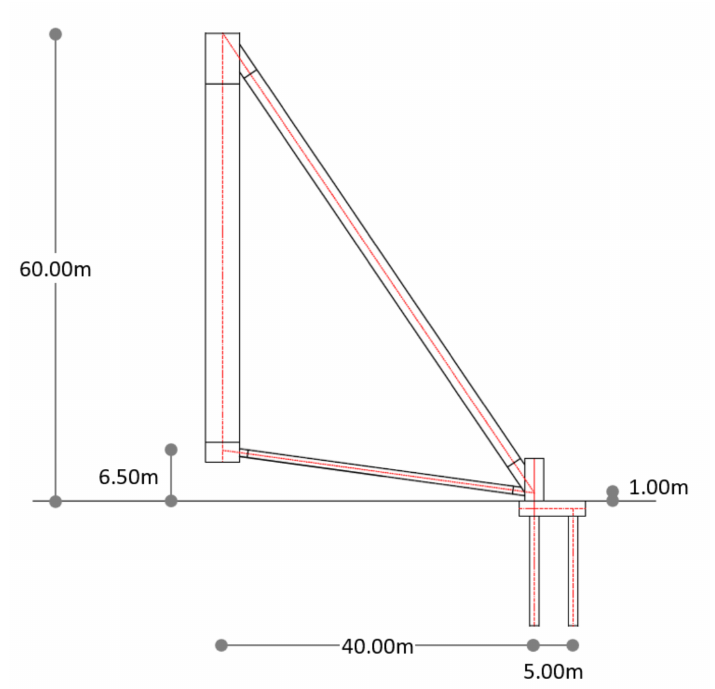
Figure 10. Case study geometry.